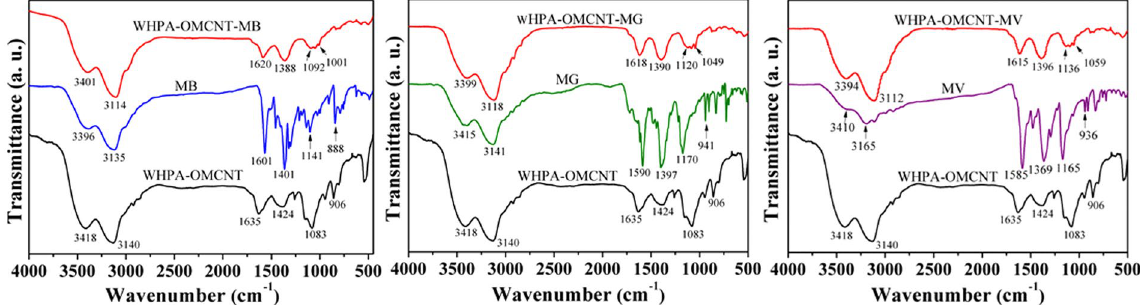
Figure 6. FTIR spectra of WHPA-OMCNT before and after loading MB (WHPA-OMCNT-MB), MG (WHPA- OMCNT-MG) and MV (WHPA-OMCNT-MV).